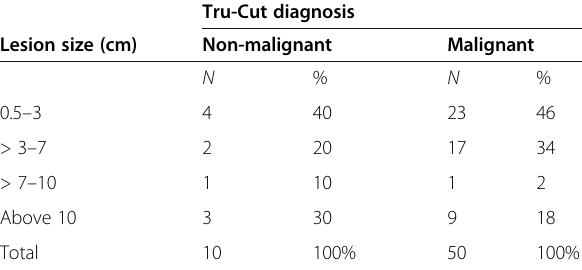
Table 10 Lesion size in malignant and non-malignant by